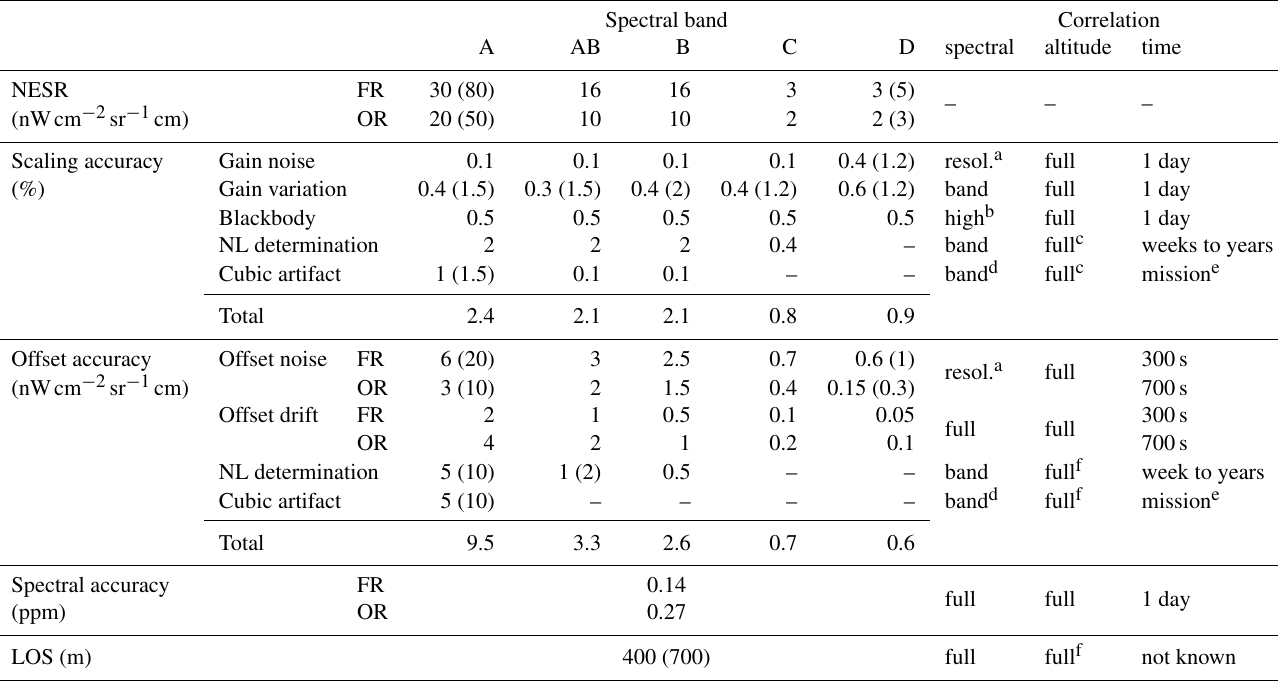
Table 3. Summary of the level 1b data accuracy. NL is nonlinearity. For details, see